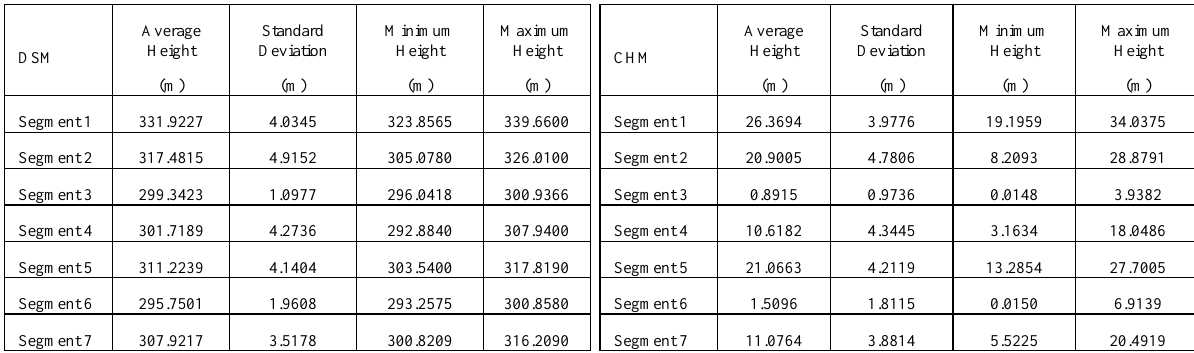
Table 2 . The four attributes for the first 7 individual tree segments on DSM image